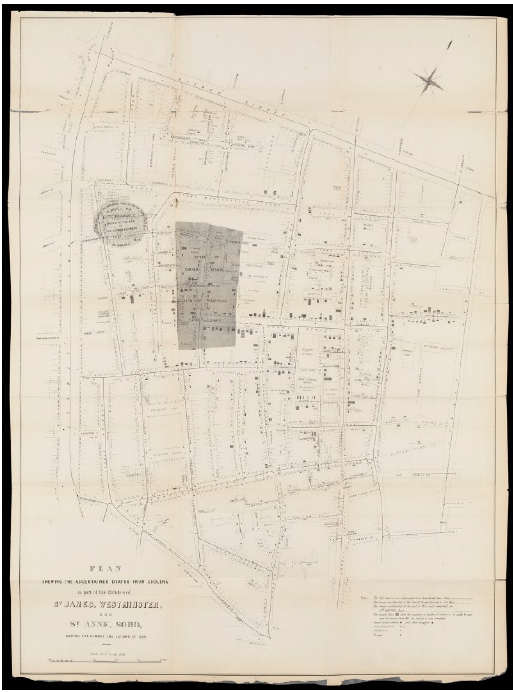
Figure 1. A map of Soho, London, created by John Snow to record the number of cholera deaths.